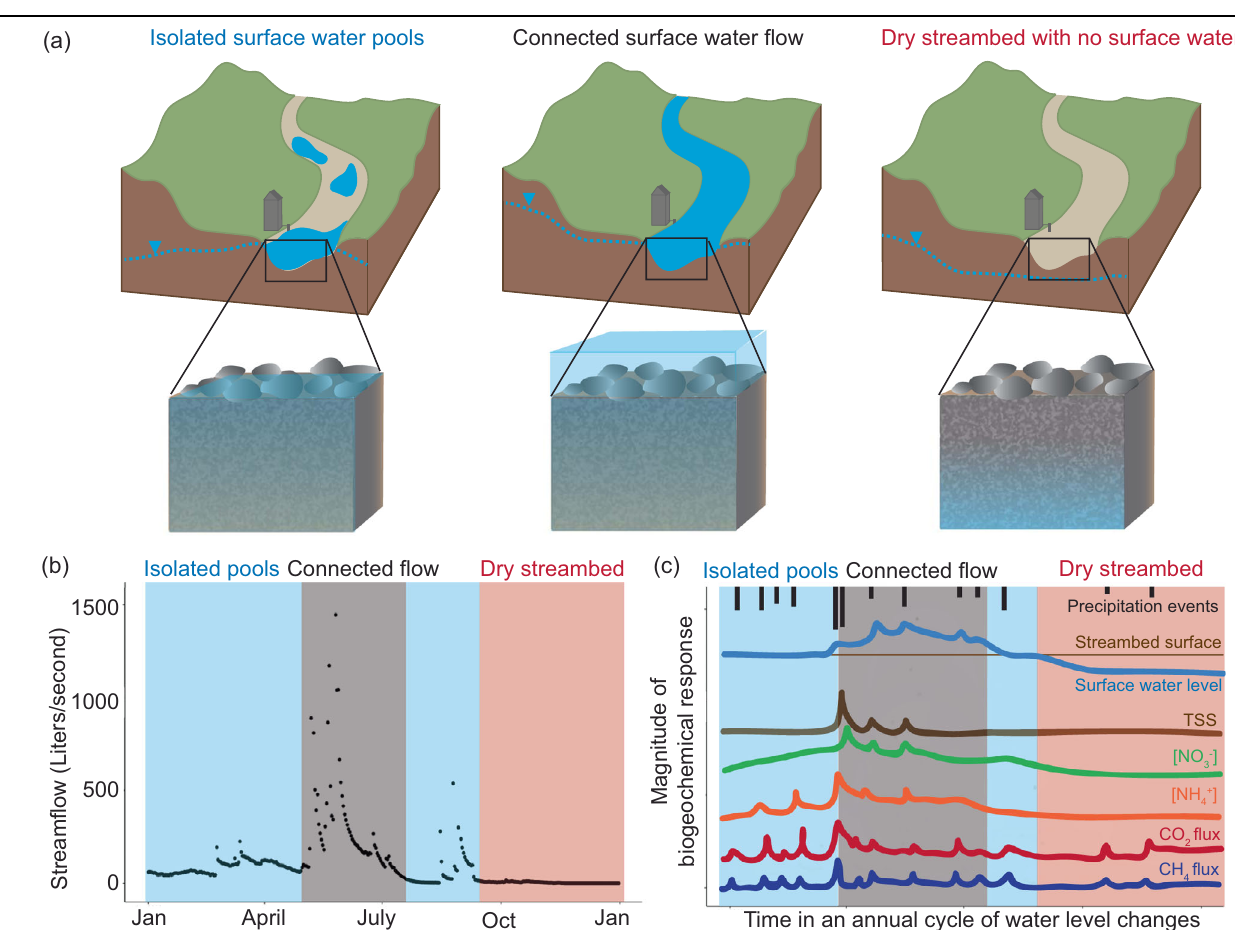
Fig. 1 | Biogeochemical response examples to different in-stream hydrologic conditions. a Illustrations of reach scale and streambed hydrologic conditions during periods with (left to right): isolated surface water pools, connected surface fl ow, and a dry stream with no surface water. b Example stream fl ow hydrograph with periods of isolated surface water pools (blue), connected surface water fl ow (gray), and dry streambed (red). Stream fl ow data from Konza Prairie Biological